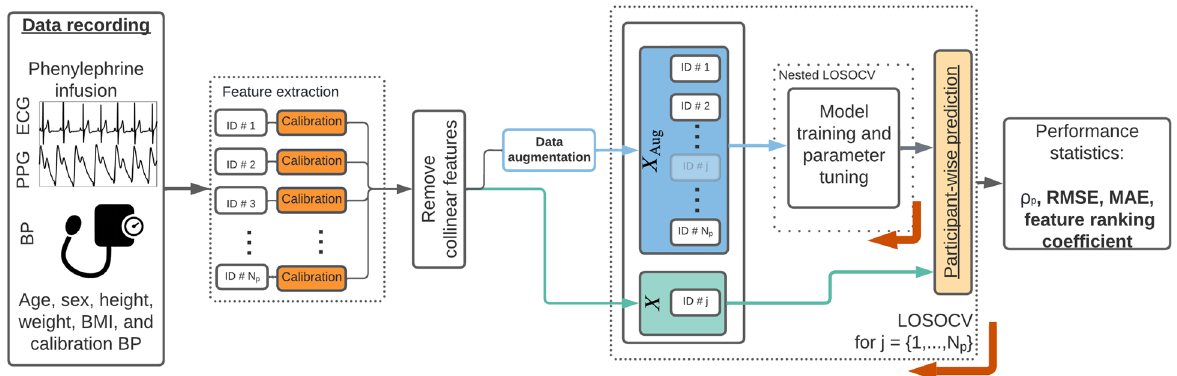
Figure 2. Schematic of the (cid:31) BP estimation pipeline for each of the proposed models. We extracted features from the PPG and ECG and averaged their values within a window of size 40s centred on times of cuff inflations. We then implemented a hybrid calibration approach such that the proposed models estimate (cid:31) BP from a baseline calibration value determined during the rest period. Data augmentation was implemented to increase the training and validation set size by interpolating between cuff inflations. Models were trained and evaluated in a nested leave-one-subject-out cross-validation (LOSOCV) framework shown here by the iterator j which indicates the test participant for that iteration. Participant j was then removed from the training/ validation set ( X Aug ) for that